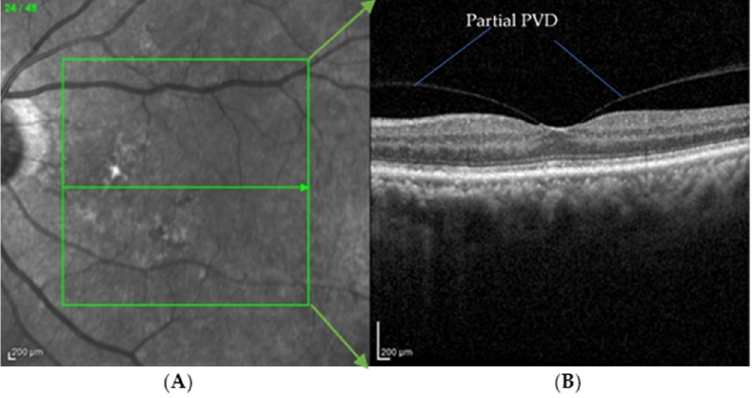
Figure 7. Partial PVD in OCT image: ( A ) fundus image; ( B ) corresponding OCT Image below the